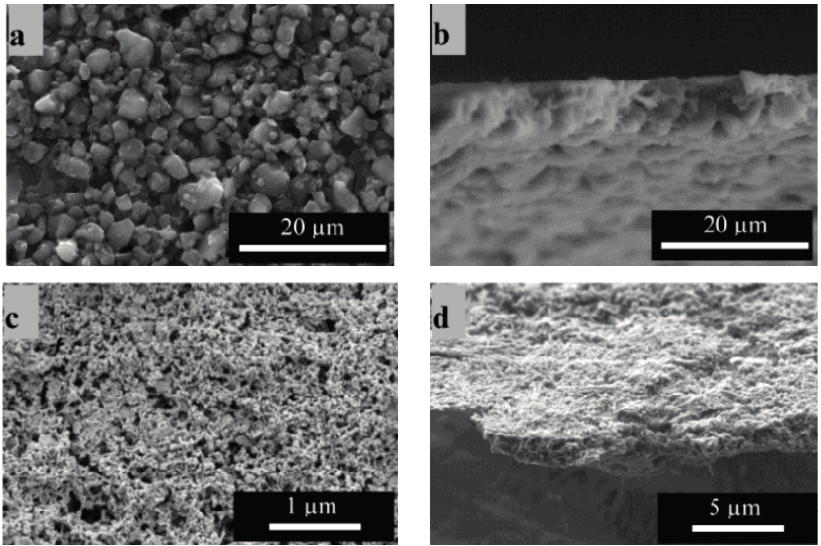
Figure 1. ( a ) Surface and ( b ) cross sectional views of chitosan-bioactive glass (BG) composites (containing BG micro particles); and ( c ) surface and ( d ) cross sectional views of chitosan-BG composites (containing nanoscale BG particles).